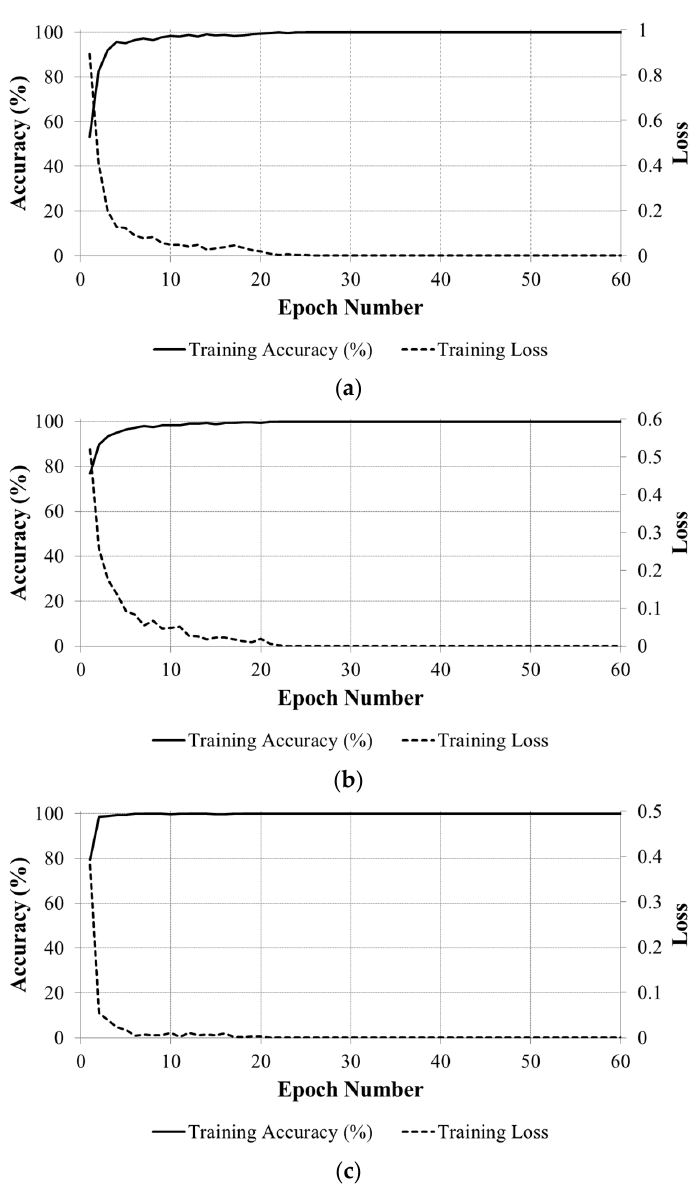
Figure 7. Convergence graphs with average accuracies and losses according to the epoch number on two subsets of training data in two-fold cross-validation on each national currency dataset: ( a ) KRW; ( b ) INR; and ( c ) USD.